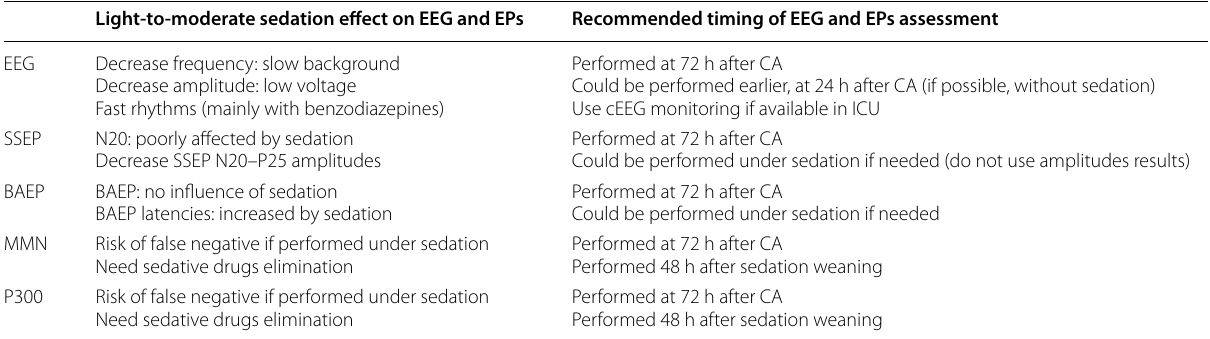
BAEP brainstem auditory evoked potentials; EEG electroencephalogram; ERP event-related potentials; MMN mismatch negativity; SSEP somato-sensory evoked potential. ICU intensive care unit